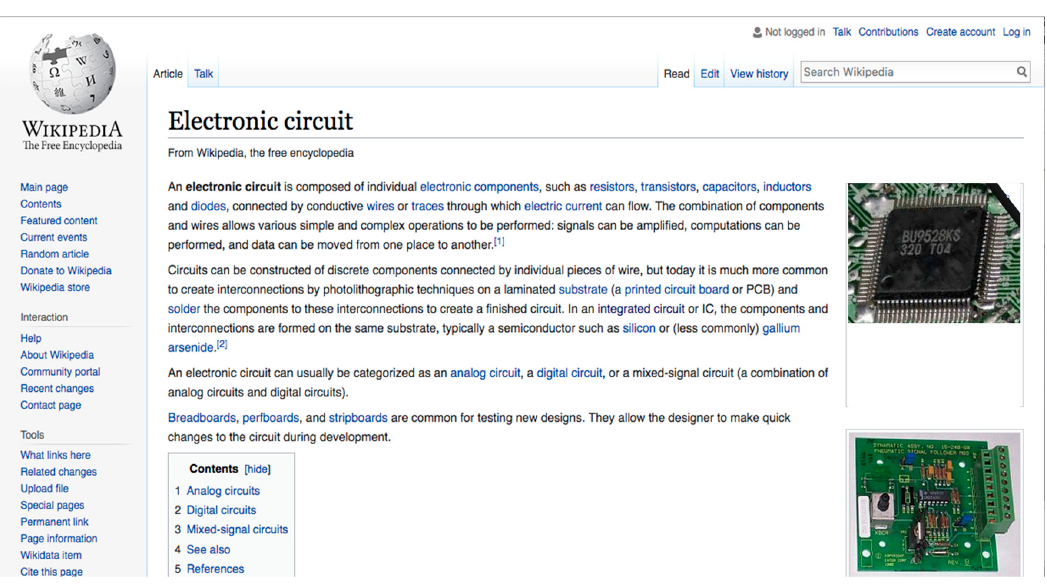
Figure 3. Screenshot of Electronic Circuit. Wikipedia: The Free Encyclopedia . San Francisco: Wikimedia